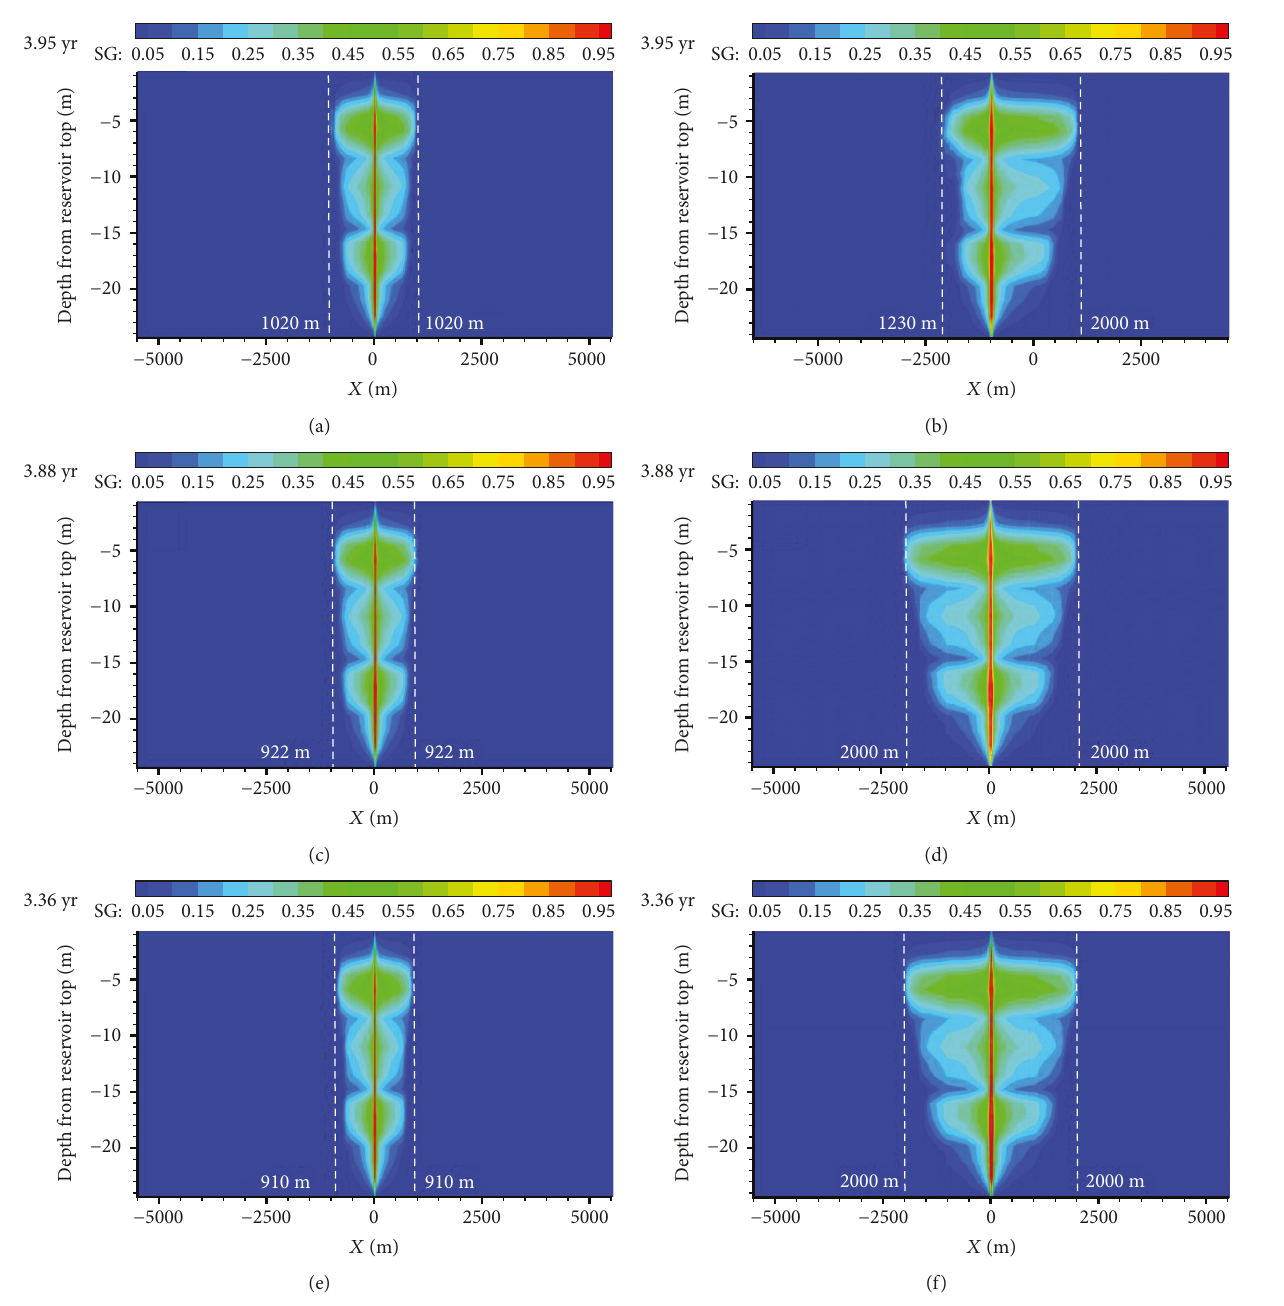
Figure 7: Spatial distribution of the supercritical CO at the end of the simulation in di ff erent scenarios (analysis of number of the production 2 wells). (a) Sole CO injection at 3.95 years. (b) One production well at 3.95 years. (c) Sole CO 2 at 3.88 years. (e) Sole CO injection at 3.36 years. (f) Four production wells at 3.36 2